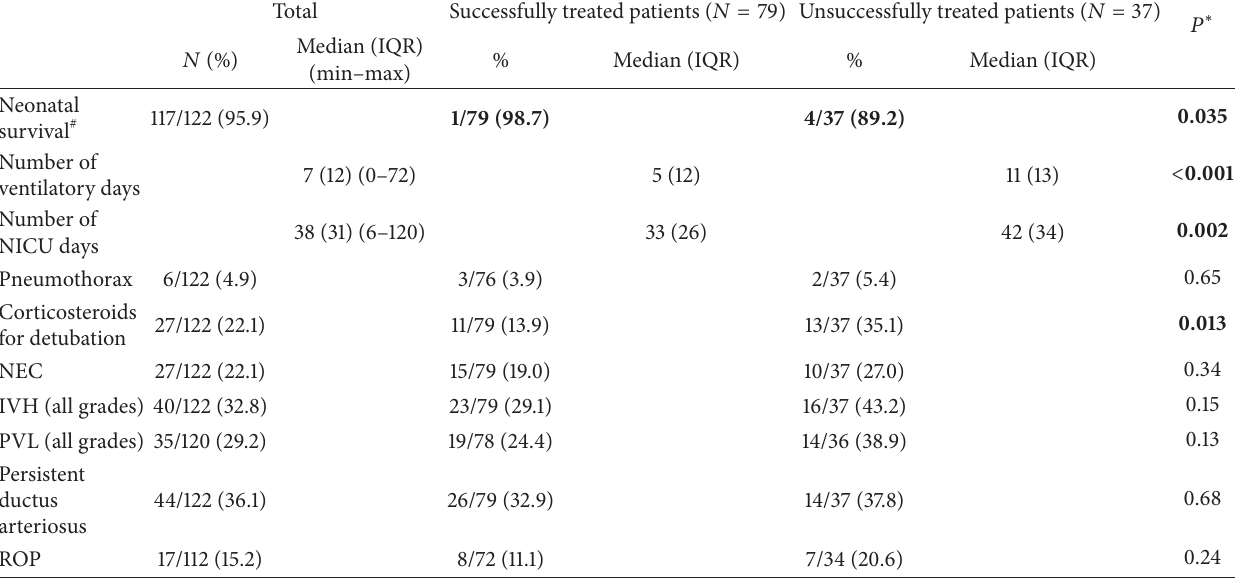
Table 3: Short-term outcome of the patients who received